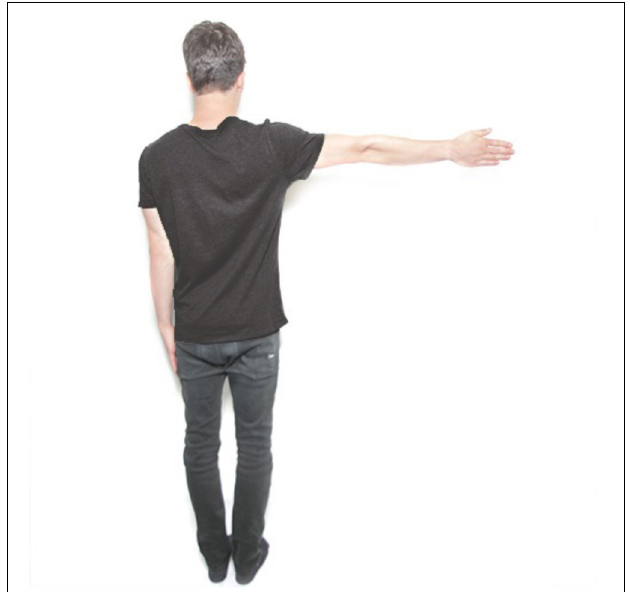
FIGURE 2 | Example of the stimuli used for the different conditions. Egocentric transformation of a male stimulus in back view condition (0 ◦ condition). Written informed consent was obtained for the publication of this image.